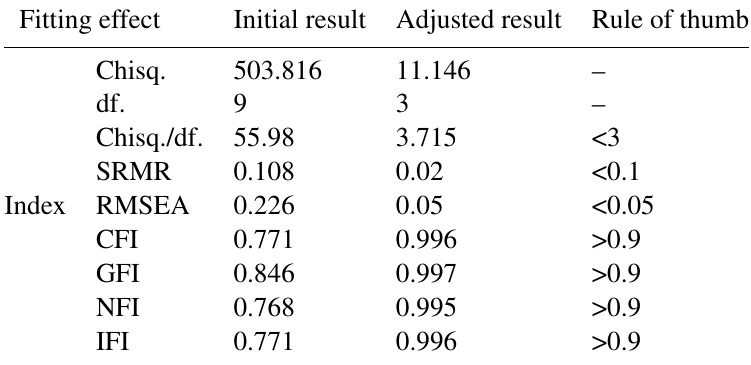
Table 3 The initial fit index of the "attitude" factor measurement